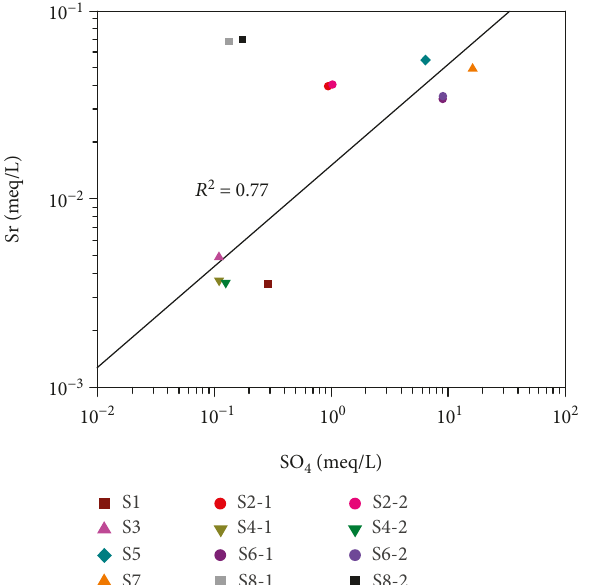
and temperature in the spring 2